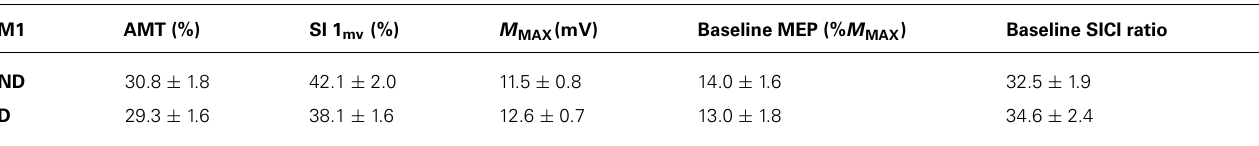
Table 1 |Average ± SEM baseline values for corticospinal excitability and intracortical inhibition in of the non-dominant and dominant